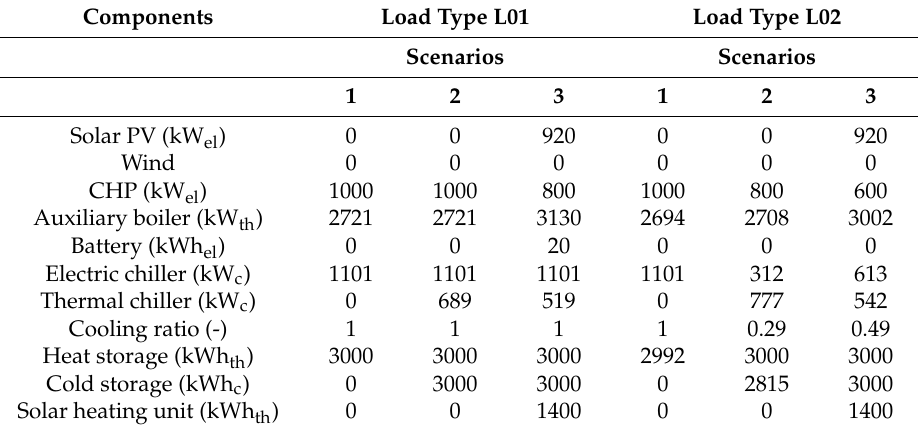
Table 7. Optimal solution for each scenario and load